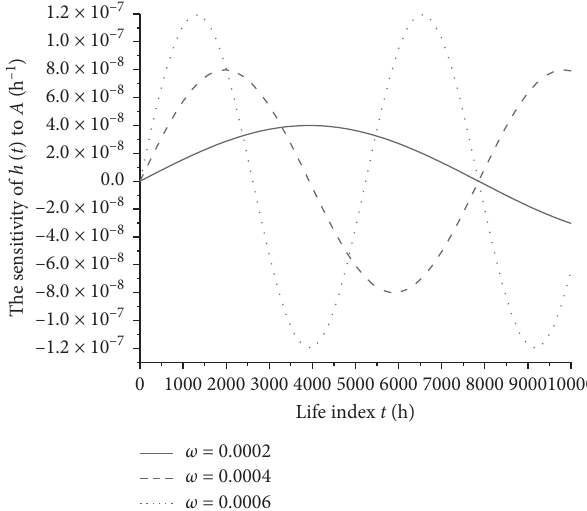
Figure 36: The sensitivity of h ( t ) to A ( ω �